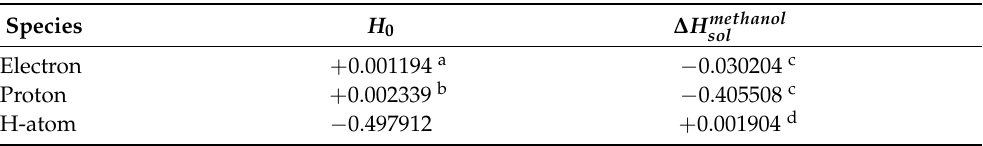
Table 3. Gas phase enthalpies H 0 and solvation enthalpies ∆ H sol in hartree utilized in the present calculations. For the for the gas phase enthalpy of the H-atom we used the value for the B3LYP/6- 31+G(d,p) electronic energy ( − 0.500273hartree) and the value of 1.4816kcal/mol for thermal correc- tion to enthalpy common for all compound model chemistries from GAUSSIAN 16. Species H 0 ∆ H methanol sol Electron + 0.001194 a − 0.030204 c Proton + 0.002339 b − 0.405508 c H-atom − 0.497912 + 0.001904 d